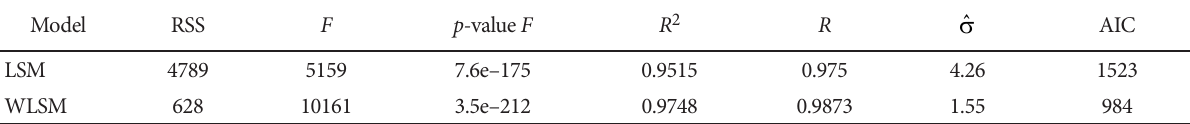
Table 5. Quality comparison of estimated models